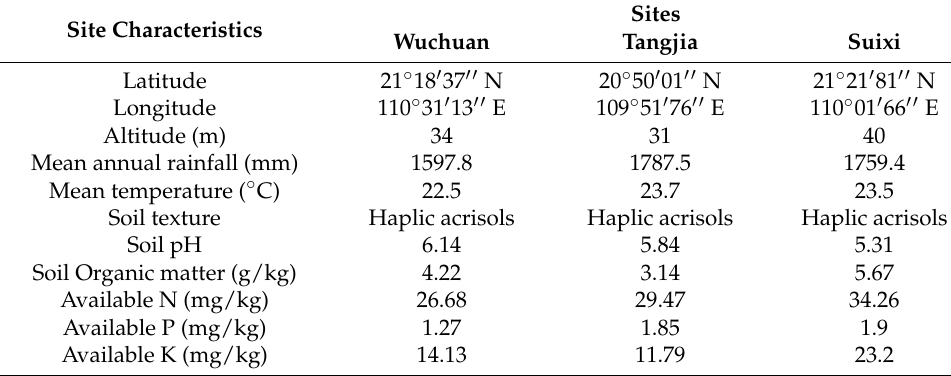
Table 1. Study area